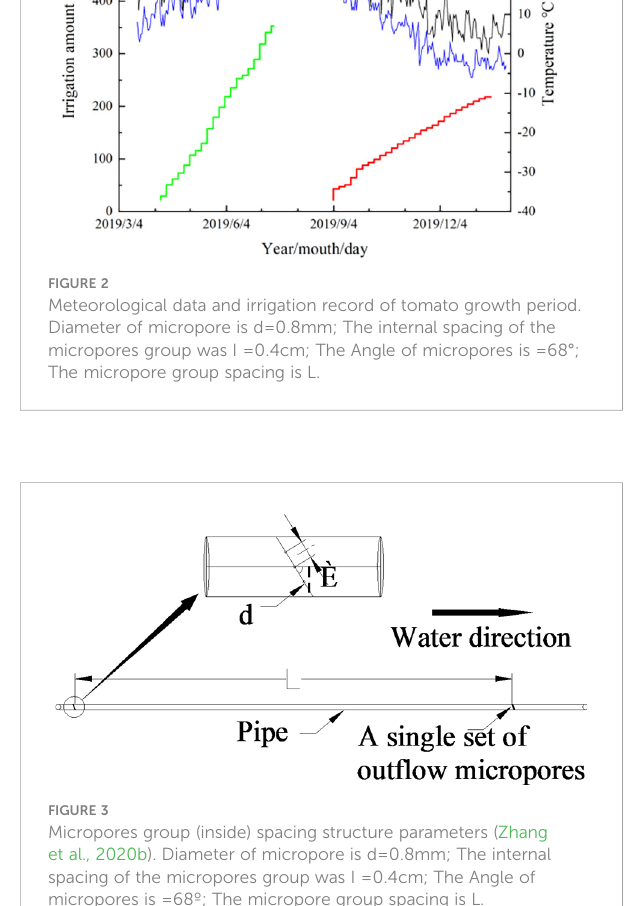
laboratory on ice. The samples were brought back to the room and the fresh soil plant residues were removed. Three soil samples in the plot were fully stirred and evenly mixed as soil samples for sequencing in the experimental plot. The soil samples were